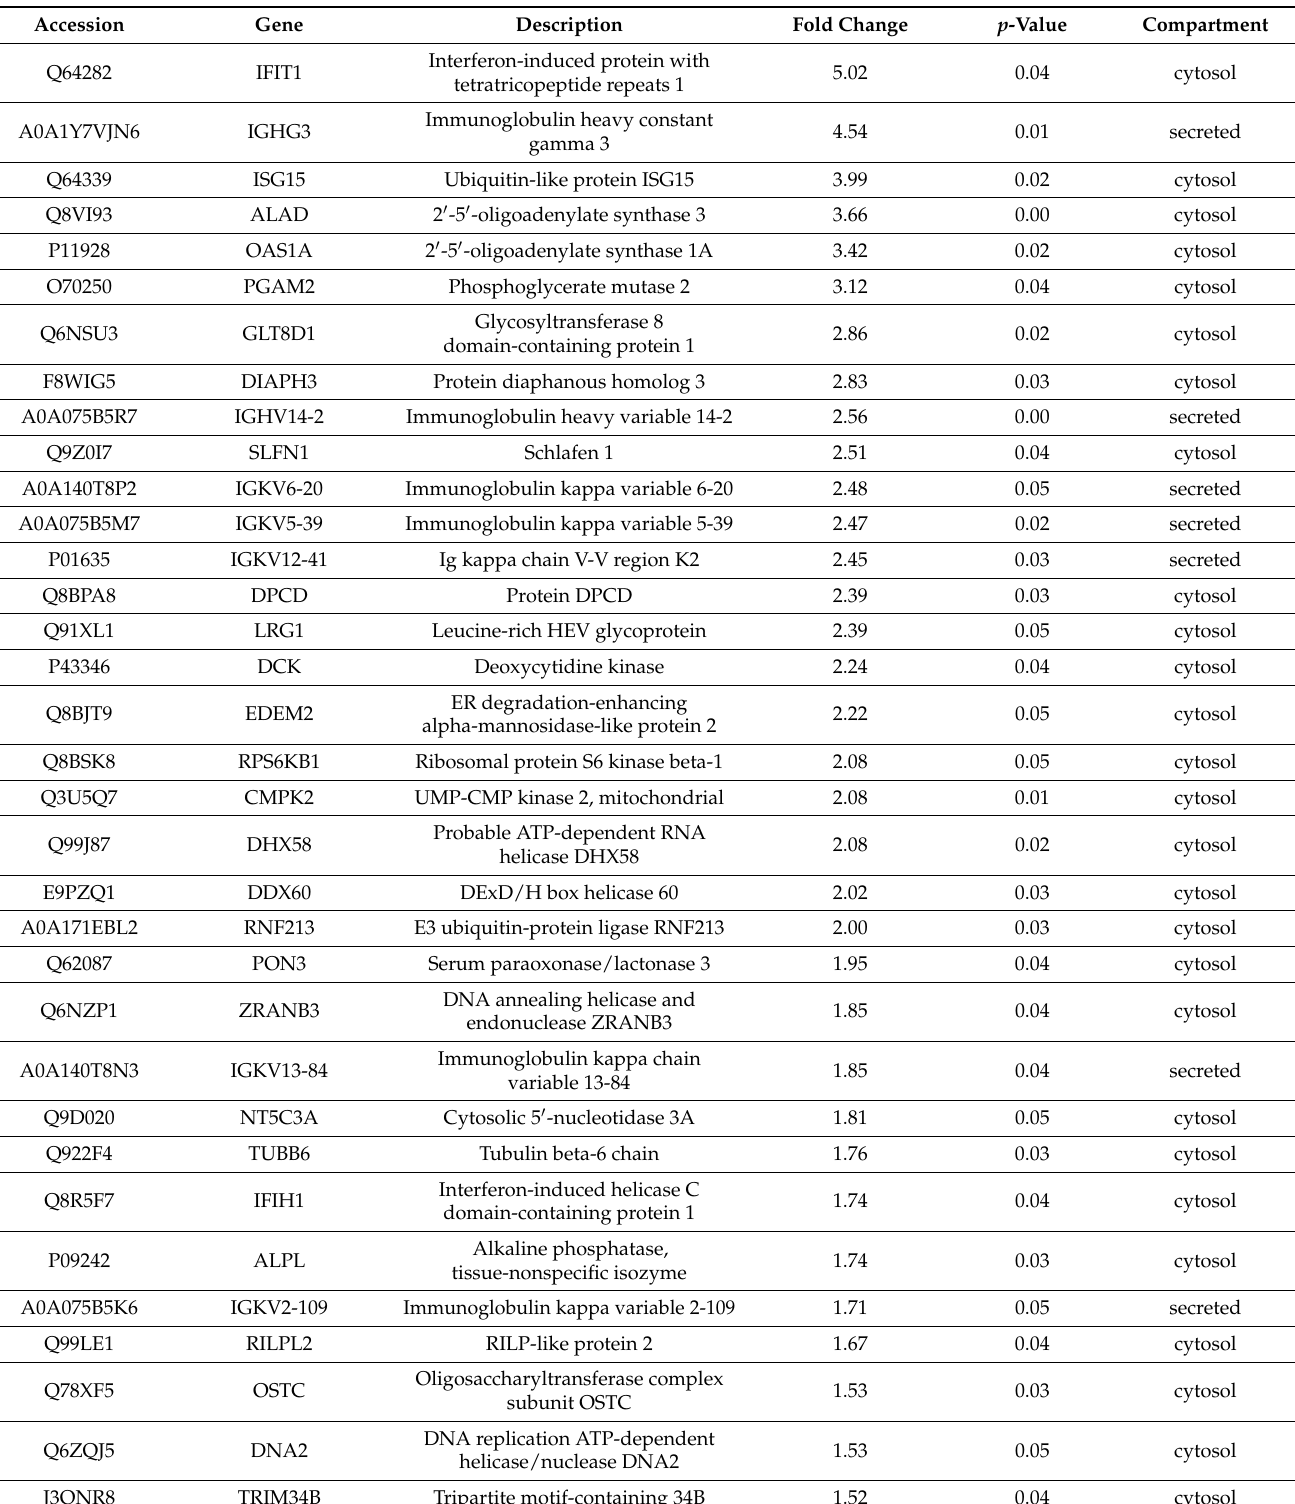
Table 1. Proteins from B cells differentially expressed in between mice stimulated with and without imiquimod and positively selected with CD19+ surface markers and then with 1.5 times of change and with p -value <